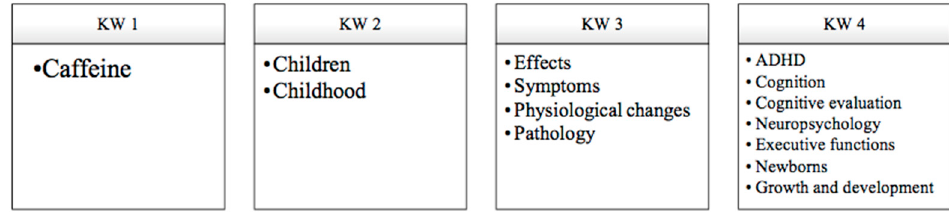
Figure 2. Search criteria for information and keywords (KW).